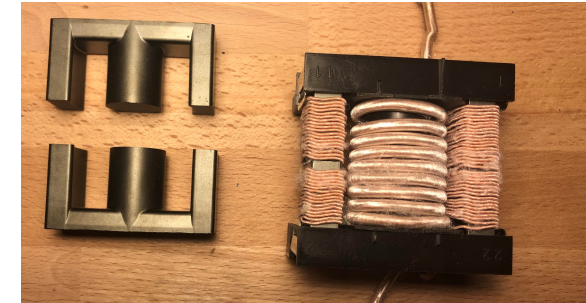
Figure 7. SiC MOSFET driver.